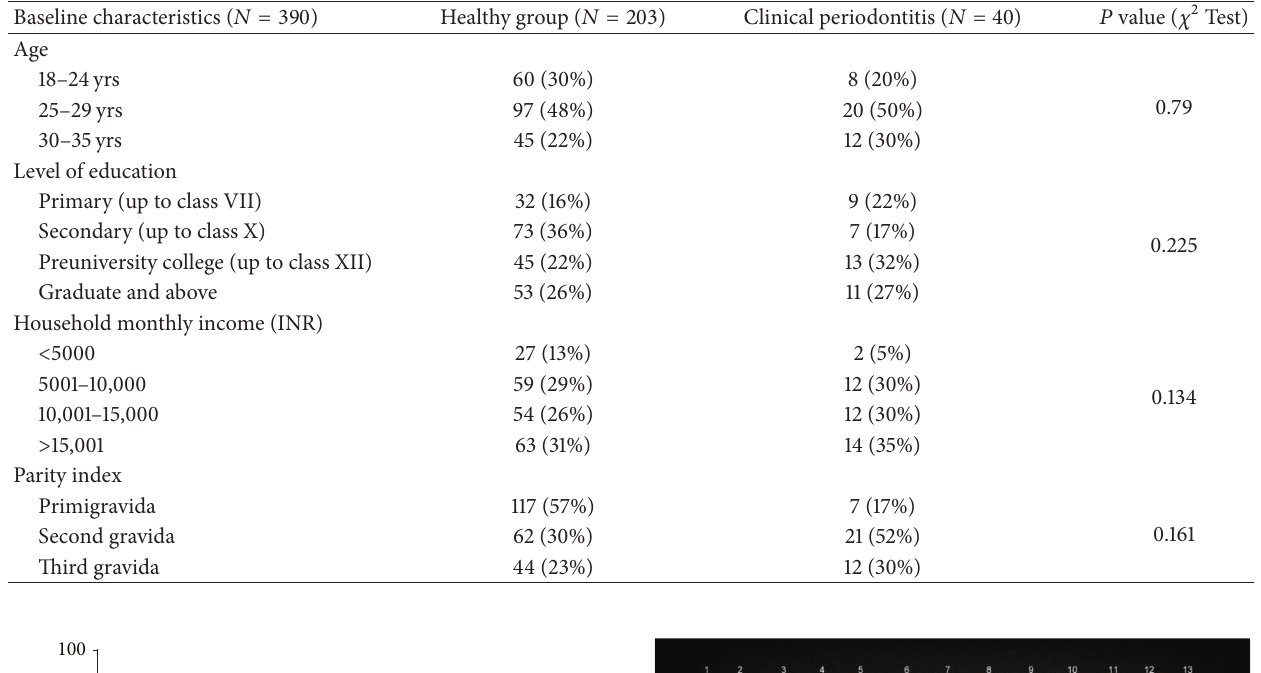
Table 3: Association of baseline sociodemographic characteristics with clinical periodontitis.